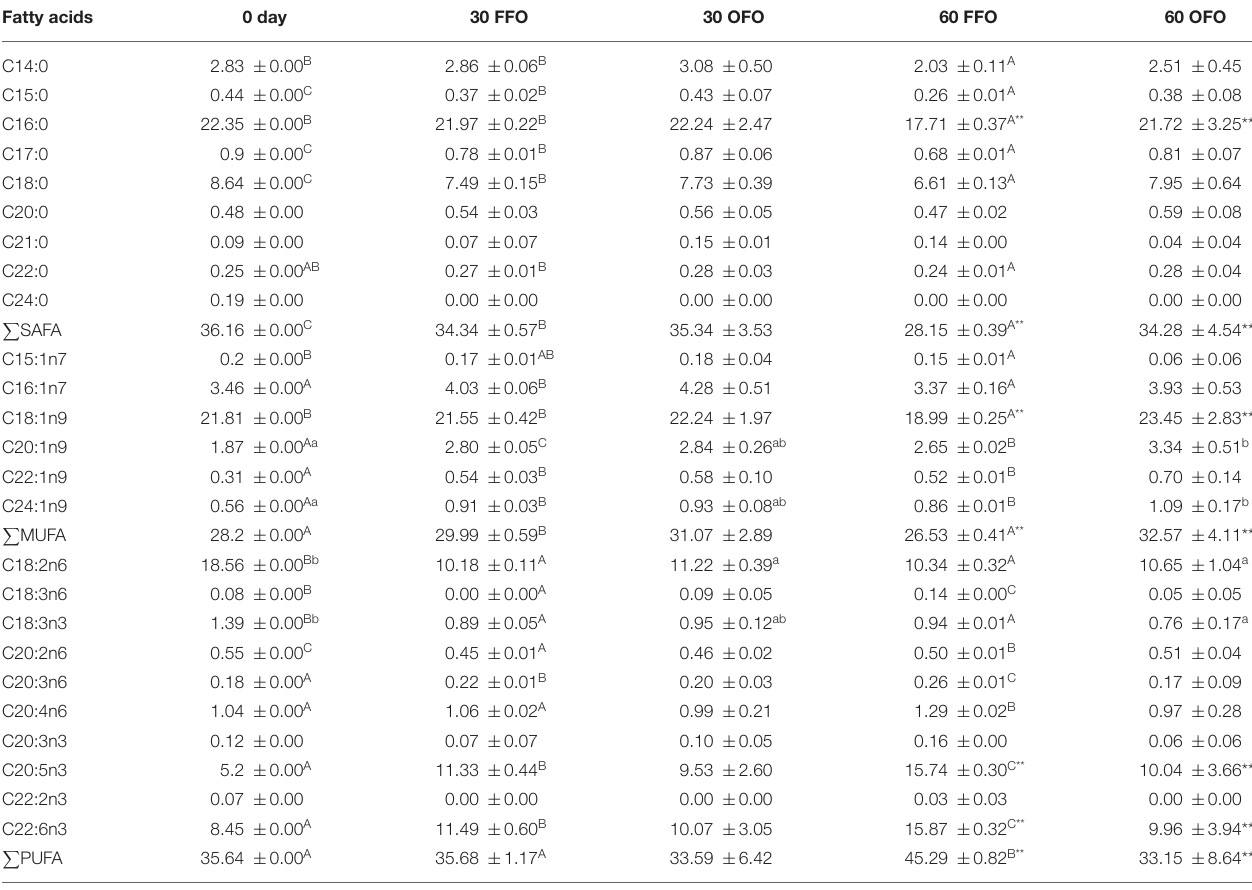
TABLE 5 | Muscle fatty acids of grouper fed different diets %. Fatty